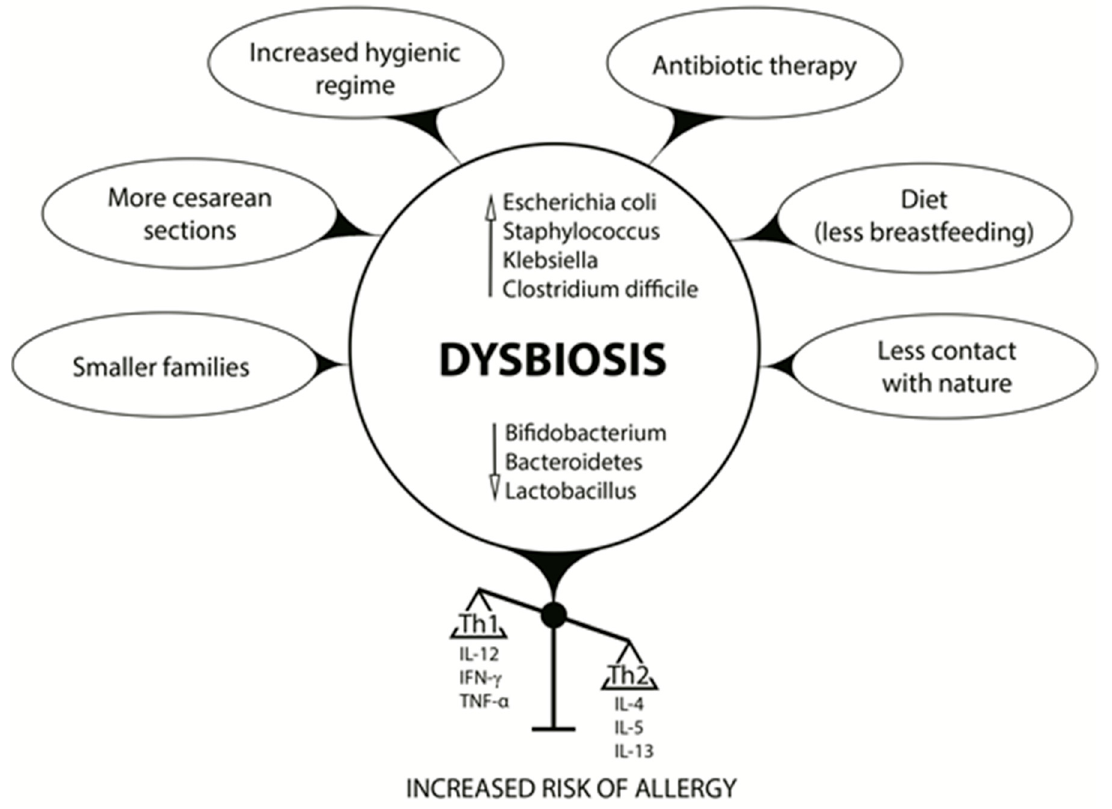
Figure 1. Factors a ff ecting the formation of intestinal microbiota that induce dysbiosis and increase the risk of